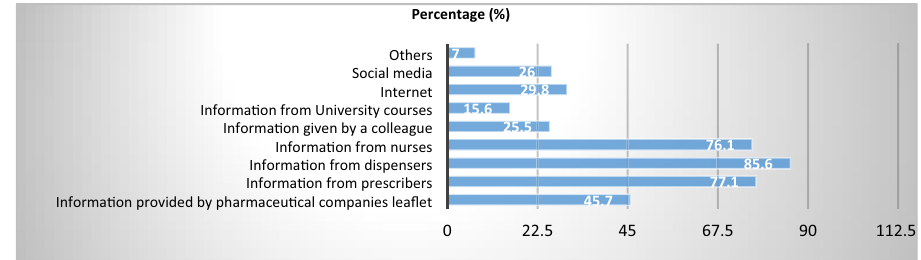
Figure 4. Parents’ source(s) of information about antibiotics. Of 2802 respondents, majority of the parents obtained their information from dispensers 85.6% followed by prescriber 77.1%) then nurses 76.1%. Few